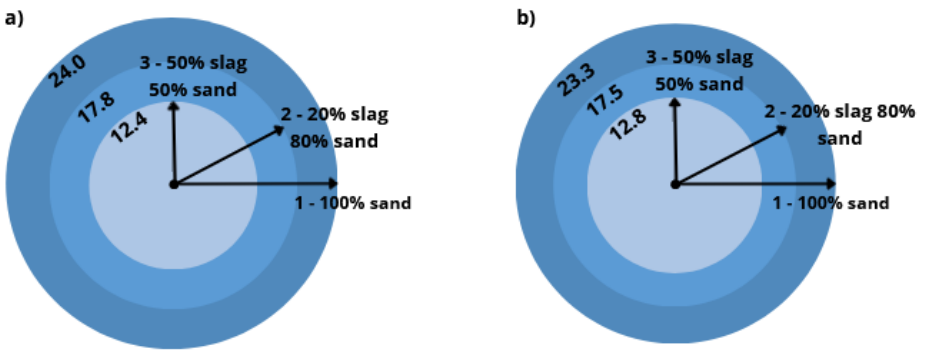
Figure 6. Consistency of fresh mortars based on sand and slag, with cement 42.5 ( a ) and cement 52.5 ( b ).